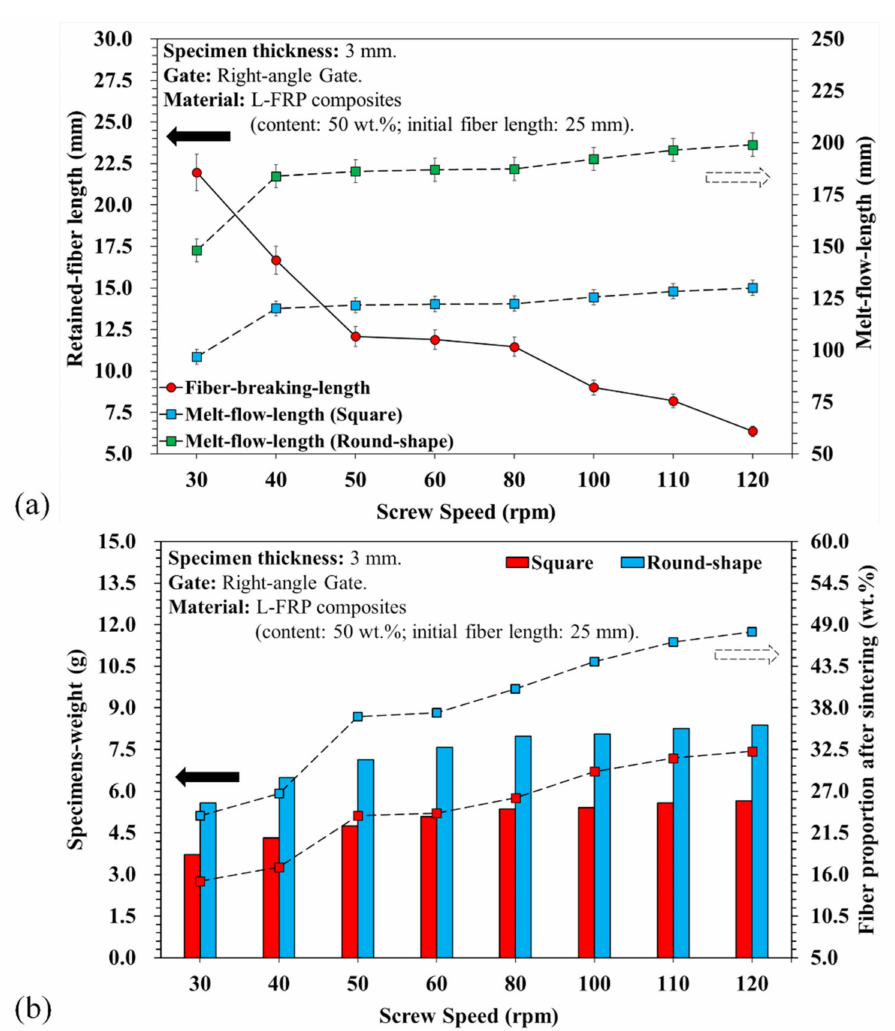
Figure 4. ( a ) Fiber breaking length variations of the melt flow length with different screw speeds and melt fill paths; ( b ) measurement of the average specimen original weight and calculation of the fiber-proportion after